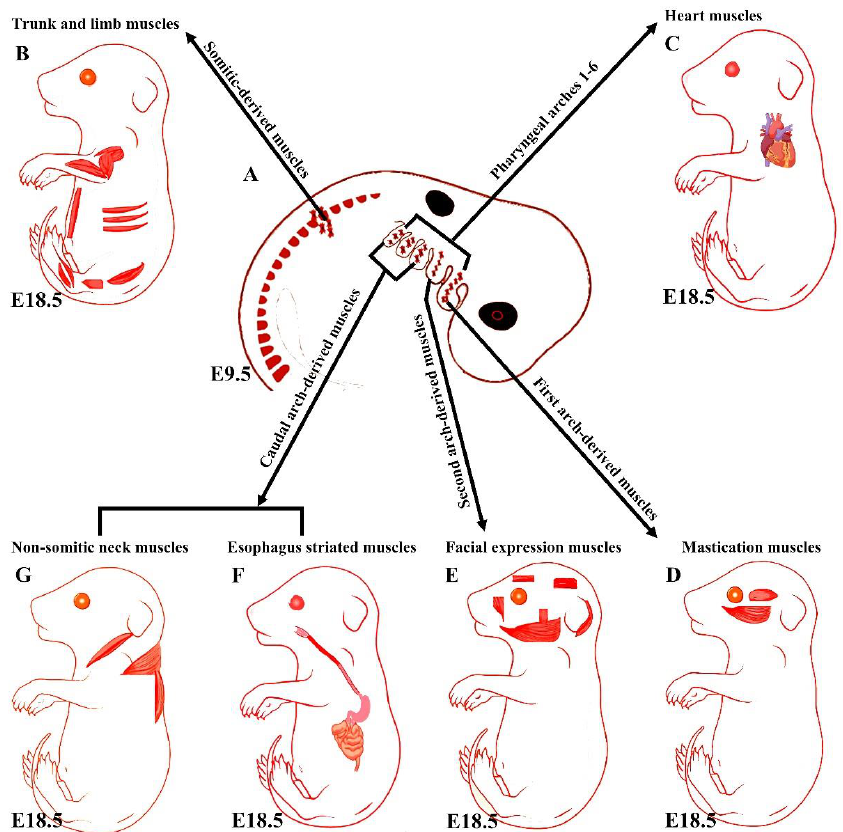
Figure 1. Summary of the embryonic origins of the branchiomeric and trunk muscles. ( A ) The bran- chiomeric muscle anlagen and second heart field progenitor cells originate from the cardiopharyngeal mesoderm that colonizes the core of the pharyngeal arches. ( B ) The somitic mesoderm gives rise to trunk and limb muscles. ( C ) The cardiopharyngeal mesoderm of arches 1 – 6 gives rise to cardiac muscle. ( D ) The cardiopharyngeal mesoderm of the first pharyngeal arch gives rise to mastica- tion muscles. ( E ) The cardiopharyngeal mesoderm of the second pharyngeal arch gives rise to facial expression muscles. The caudal cardiopharyngeal mesoderm gives rise to the striated muscles of the esophagus ( F ) and non-somitic neck muscles ( G ). Retrieved from https://app.biorender.com/bi- orender-templates (accessed on 7 July 2022).